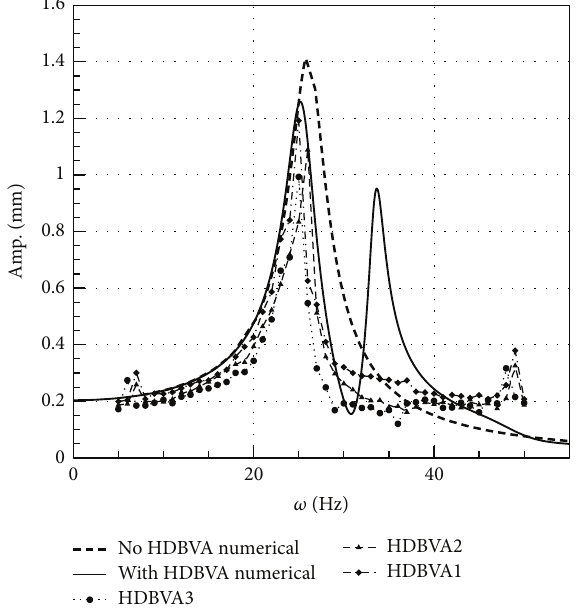
Figure 29: Frequency response of 𝜃 𝑌 DOF of case Figure 10(d), HDBVAs start at the near-force point.